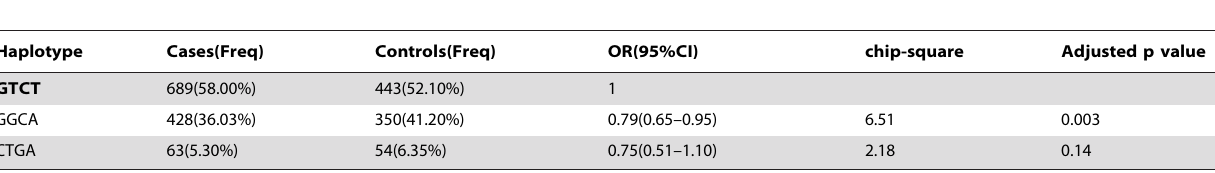
Table 6. Results of the association test for four SNPs (rs622502, rs2239751, rs6768300 and rs414171) haplotypes in Han population from southwestern China.